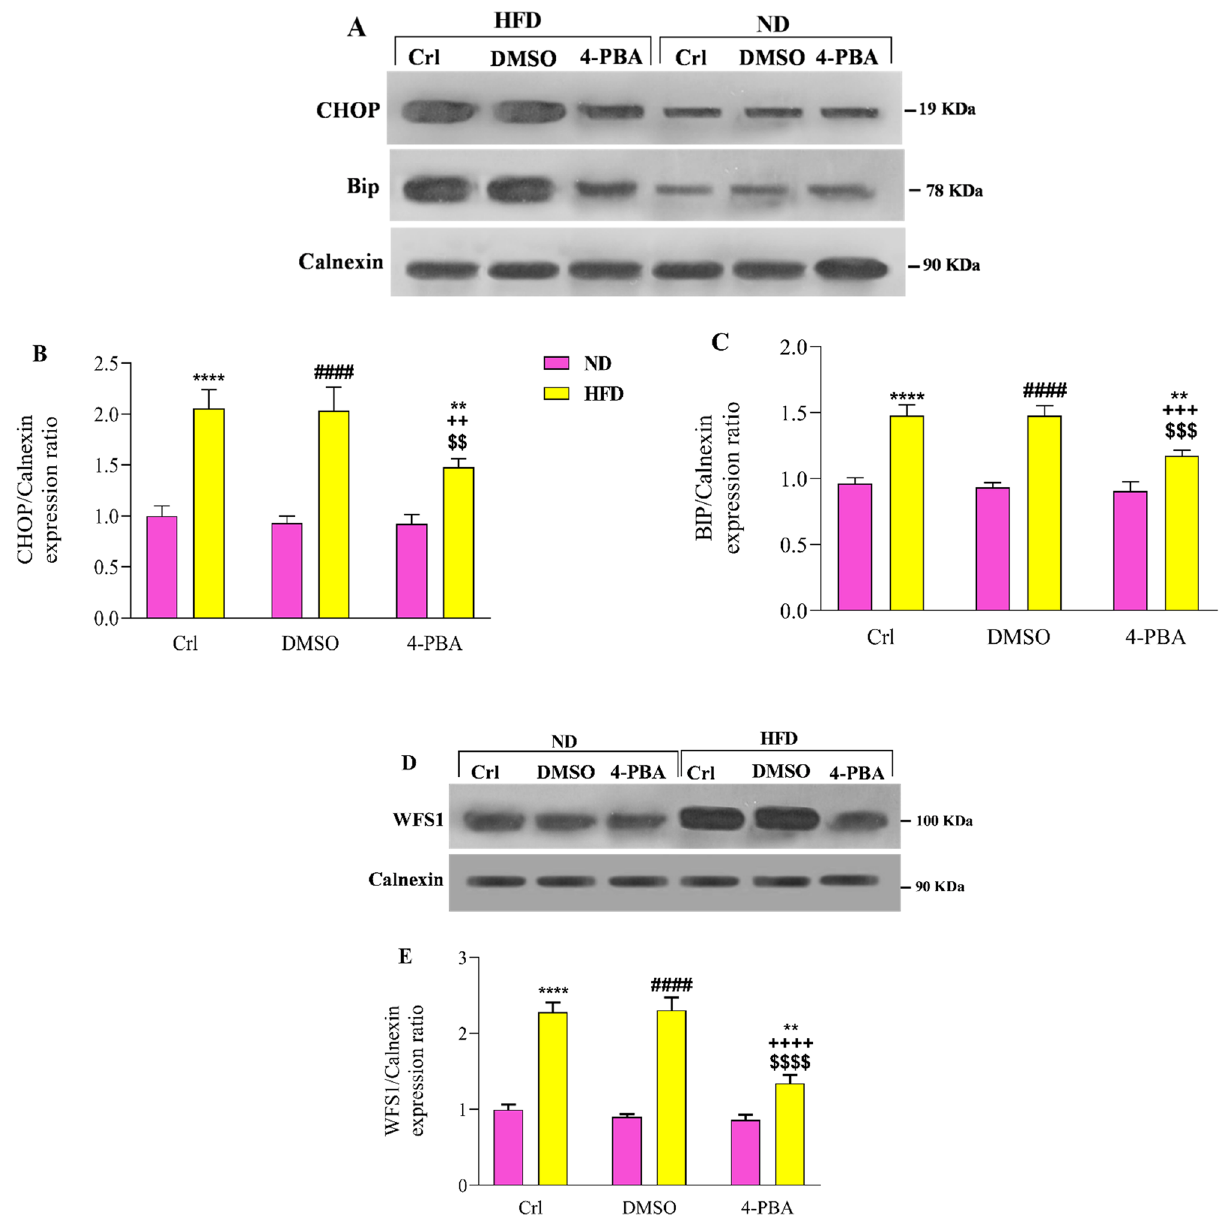
Figure 4. Effect of high-fat diet and/or 4-PBA on the ( A , B ) CHOP, ( A , C ) BIP and ( D , E ) WFS1 protein levels of the extracted ER of pancreas. Each column represents the mean ± SEM (10 rats/group). **p < 0.01, ****p < 0.0001 versus control of ND group, #### p < 0.0001 versus ND + DMSO group, $$ p < 0.01, $$$ p < 0.001, $$$$ p < 0.0001 versus control of HFD group, ++ p < 0.01, +++ p < 0.001, ++++ p < 0.0001 versus HFD + DMSO group. ND Normal diet, HFD High-fat diet, Crl Control, DMSO Dimethyl Sulfoxide, 4-PBA 4-Phenyl Butyric concentrations at 120 min than ND group (Fig. 7B). This parameter significantly increased after 4-PBA injection at all three test times in the HFD + 4-PBA group compared to that in HFD and HFD + DMSO groups (0 min (P < 0.01), 30 min (P < 0.001) and 120 min (P < 0.01), respectively) (Fig. 7B), so that this group did not show sig- nificant difference compared to ND and ND + DMSO groups at any time point (Fig. 7B). The area under the curve (AUC) of plasma insulin changes during OGTT confirmed the above mentioned explanations (inset of Fig. 7B). The effect of high‑fat diet and/or 4‑PBA on plasma corticosterone and leptin concentra‑ tions. When comparing HFD and HFD + DMSO groups to ND and ND + DMSO groups, plasma corti- costerone and leptin concentrations were substantially higher in HFD and HFD + DMSO groups (P < 0.0001) (Fig. 8A,B). The 4-PBA injection in the HFD + 4-PBA group resulted in a substantial reduction in these parame- ters, when compared to HFD and HFD + DMSO groups (P < 0.0001) (Fig. 8A,B), so that there were no significant